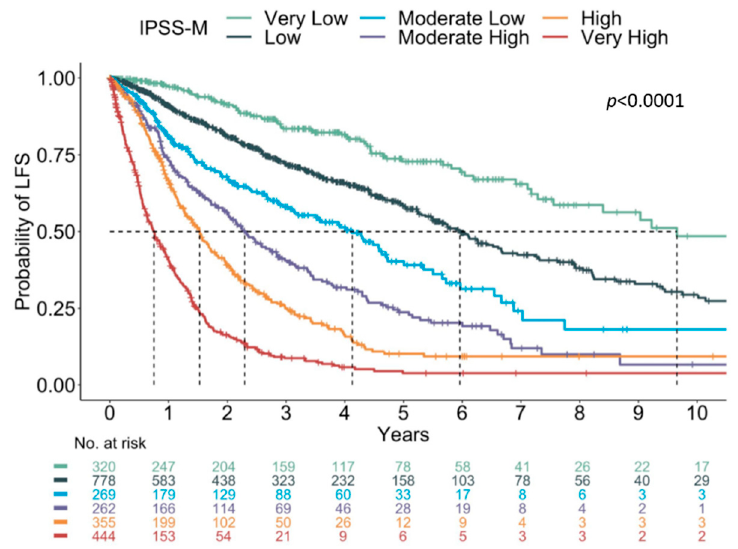
Figure 6. Kaplan–Meier curves in IPSS-M showing significant differences in probability of leukemia- free survival in each subgroup. Adapted from Bernard et al. [99]